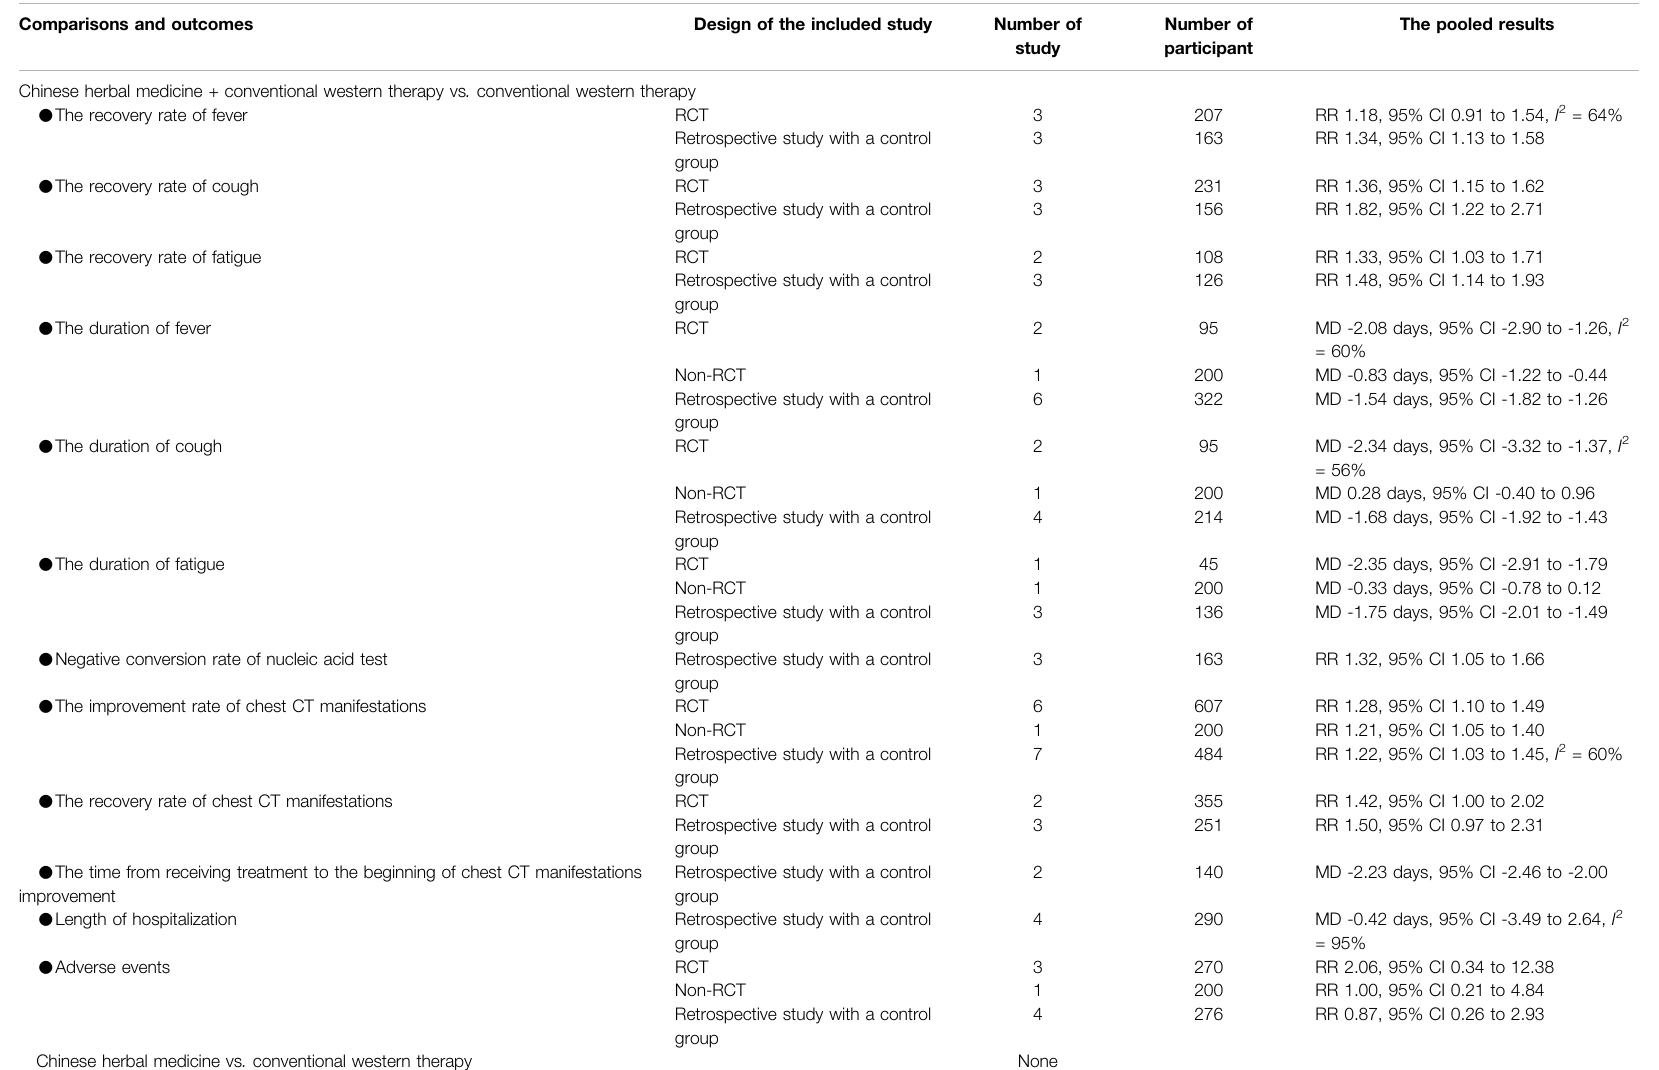
TABLE 3 | The pooled results of secondary outcomes of CHM used with or without conventional western therapy for COVID-19. Comparisons and